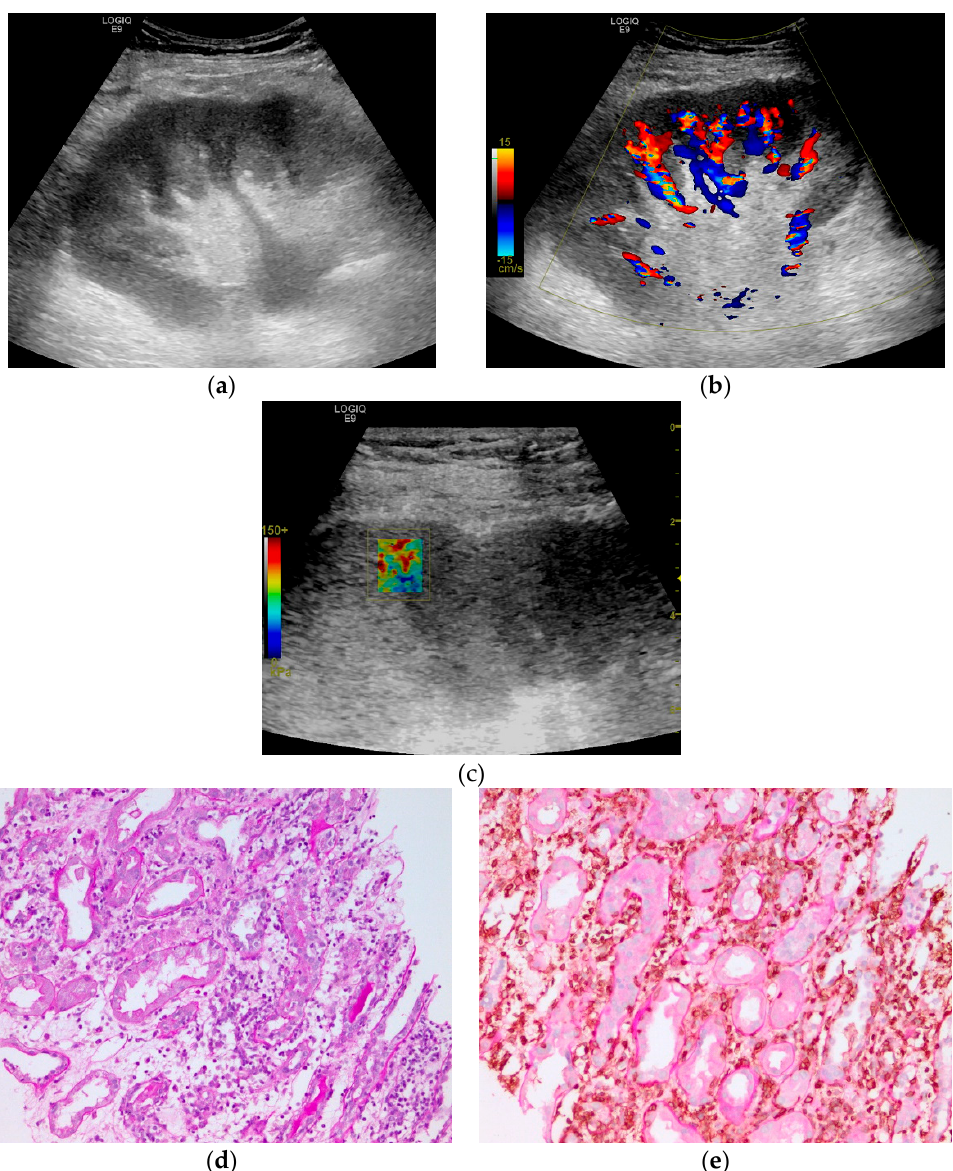
Figure 4. Ultrasound evaluation of a male patient, 62 years old, overweight, evaluated at five years after transplant. The patient was with clinical allograft dysfunction, with eGFR of 12 mL/min/1.73 m 2 and normal dose of calcineurin inhibitor. The allograft volume was 397 mL, with a parenchymal thickness of 27.1 mm and cortical thickness of 18.1 mm, high cortical–medullar differentiation and grade I hydronephrosis ( a ). Doppler signal was globally present ( b ) with all RIs (RI = resistivity index) higher than 0.8. The SWE elastogram box showed a mild heterogeneous pattern: blue-greenish background with red spot inclusion ( c ) with a median YM equal with 26.6 kPa for cortex and 10.6 kPa for medulla and high intra-patient YM heterogeneity (CQV = 30.2% for cortex and 15.6% for medulla). Microscopic examination reveals severe tubulitis in a background of interstitial edema ( d ) and inflammation (marked brown at CD45 immunostaining over PAS–Periodic Acid–Schiff–counterstaining, 20×); ( e ). The histopathological diagnostic was cellular rejection Banff IB.